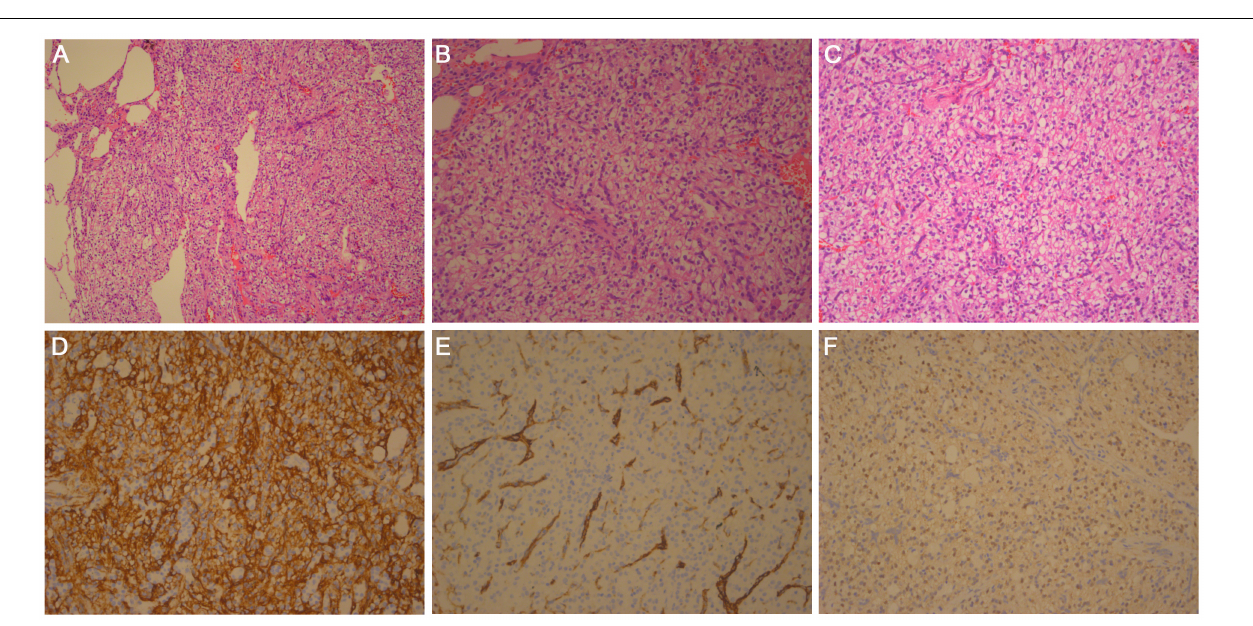
FIGURE 2 | Histologic findings: hematoxylin and eosin-stained section of (A) × 100, (B) × 200, and (C) × 400 magnifications show that the tumor boundary is clear, composed of solid, slightly lobulated flake cells with consistent morphology. Scattered dilated vacuolar components can be seen in the tumor cells. (D) Tumor cells are positive for CD34. IHC × 200. (E) Tumor cells are negative for F8, and vessel positive. IHC × 200. (F) Tumor cells are weakly positive for TFE3. IHC ×